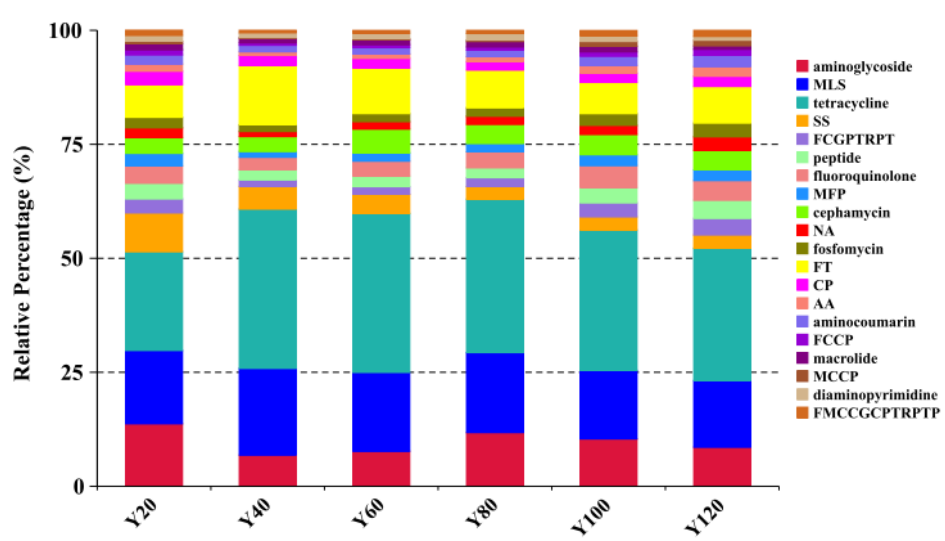
Figure 3. Comparison of the top 15 most abundant antibiotic types in the different age groups. The cumulative bar graph represents the distribution of the top 20 antibiotic resistance types in the different age groups.